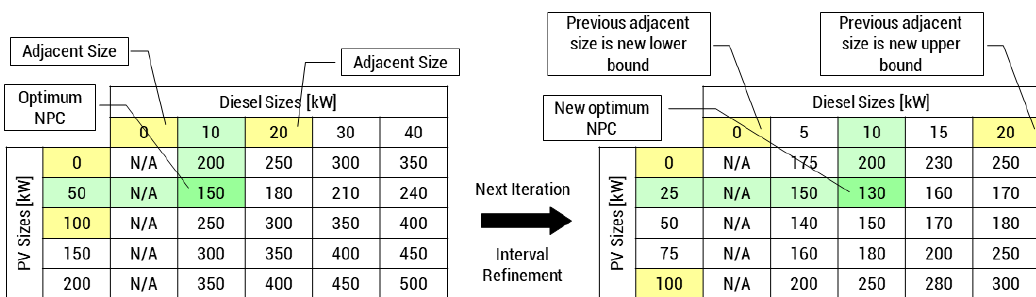
Figure 6. Iterative search space algorithm used by Island System LCOE min Algorithm (ISLA) on a hypothetical PV-Diesel system. N/A values in the figure indicate a technically infeasible system and are ignored. LCOE: levelized cost of electricity.